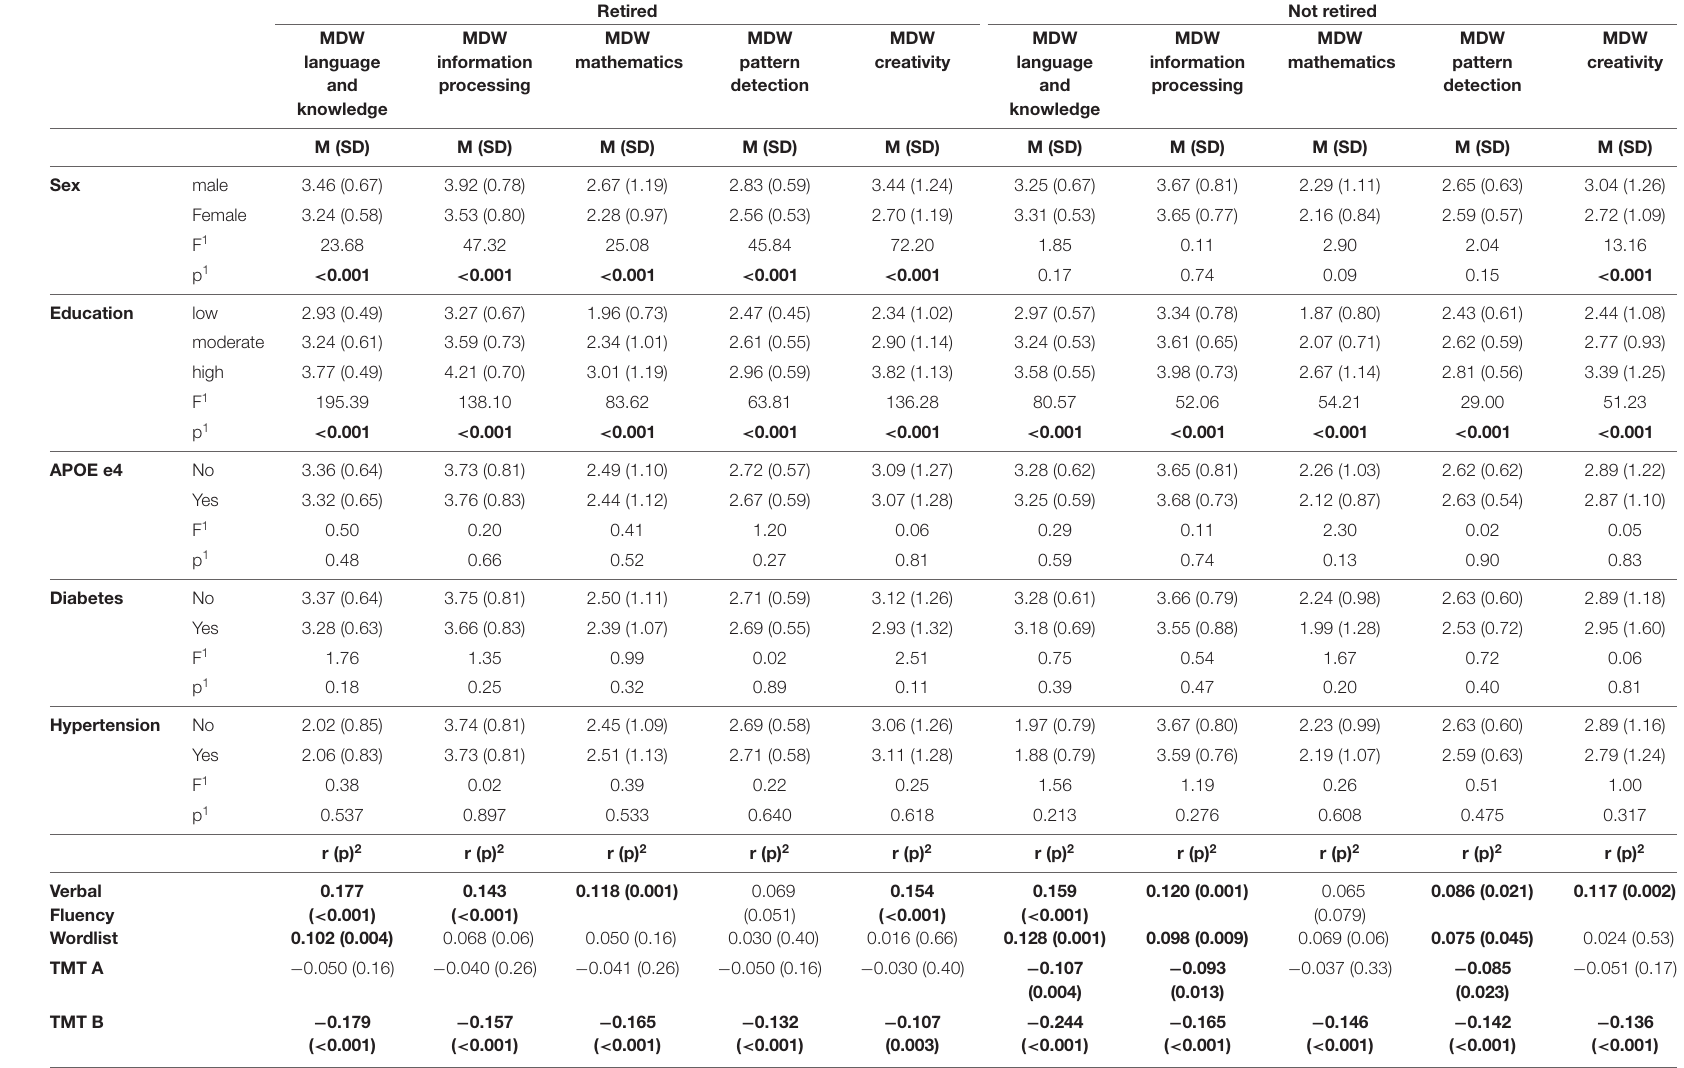
TABLE 3 | Characteristics of the study sample ( n =